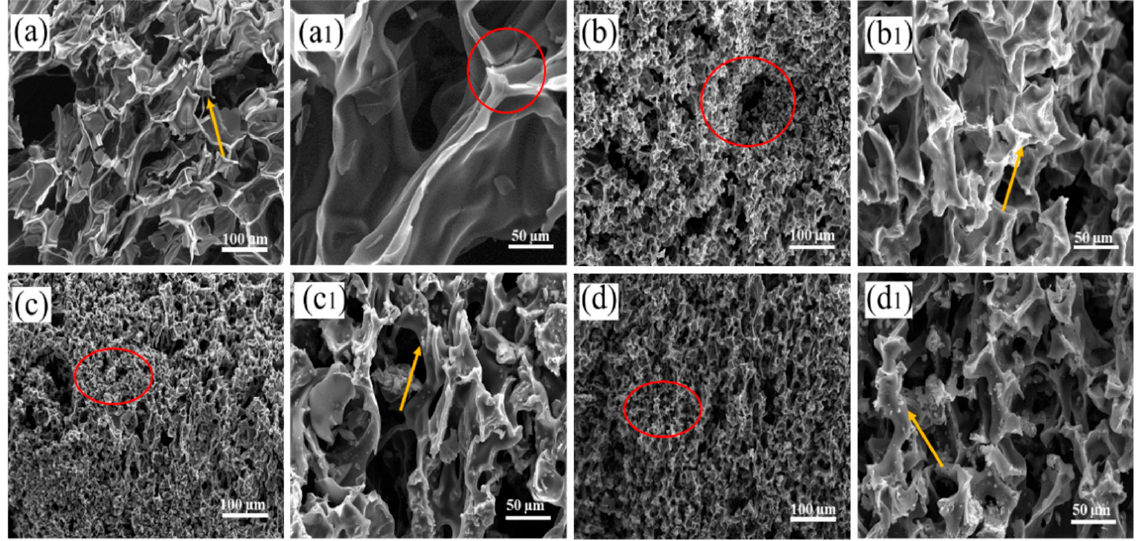
Figure 7. SEM images of RPUF and RPUF-R composite carbon slag: ( a , a1 ) RPUF; ( b , b1 ) RPUF-1; ( c , c1 ) RPUF-3; ( d , d1 ) RPUF-5.